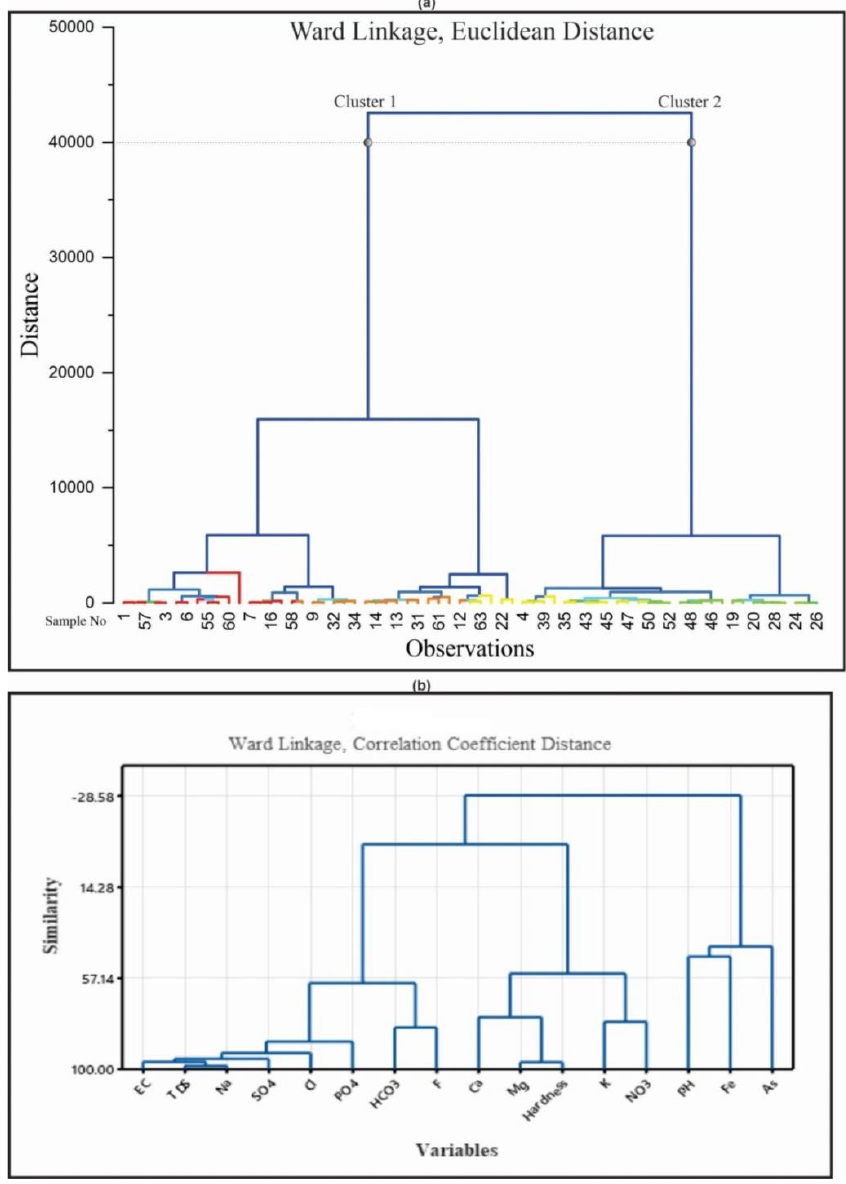
Figure 9. Dendrogram classifying hydrochemical parameters into clusters based on their chemical characteristics.